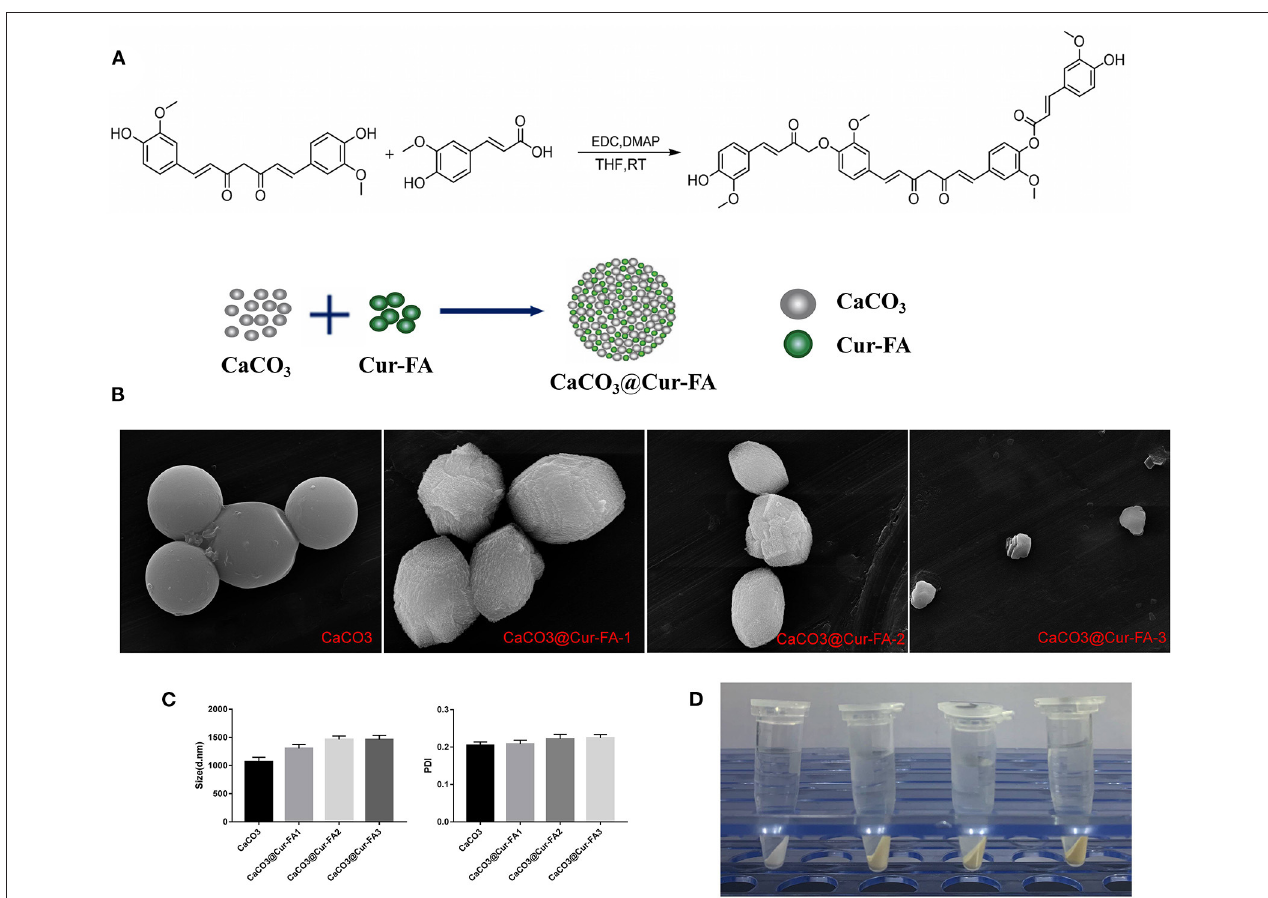
FIGURE 1 | Characterization of CaCO 3 and CaCO 3 @Cur-FA. (A) Synthesis of Cur-FA and CaCO 3 @Cur-FA. (B) SEM images of CaCO 3 and CaCO 3 @Cur-FA. Scale bar = 5 µ m. (C) Particle size and PDI for CaCO 3 and CaCO 3 @Cur-FA. (D) The images of CaCO 3 and CaCO 3 @Cur-FA.